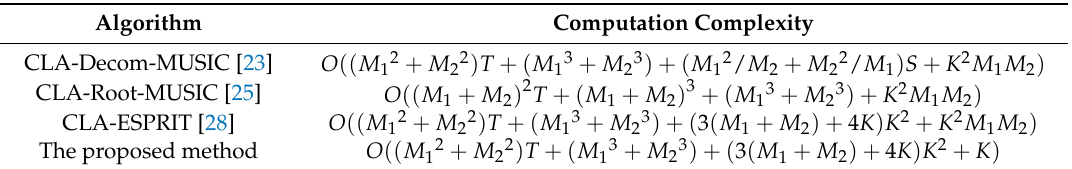
Table 2. Comparison of computation complexity.